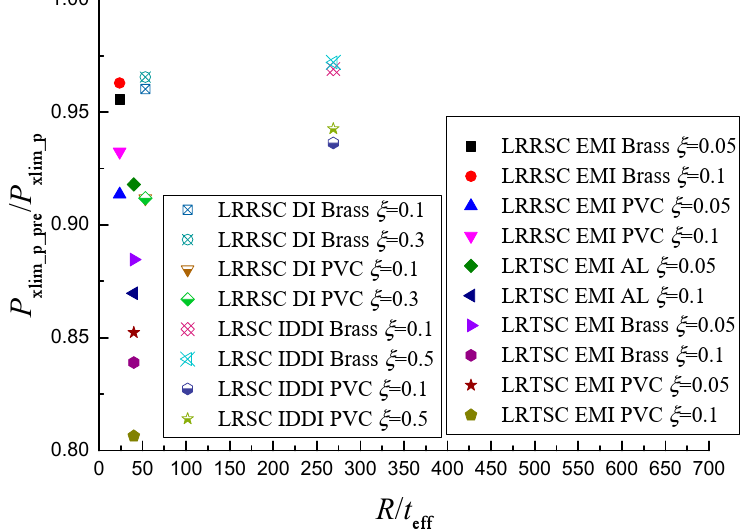
Figure 22. P xlim_p_pre / P xlim_p versus R / t eff for stiffened cylinders with initial geometrical imperfection.